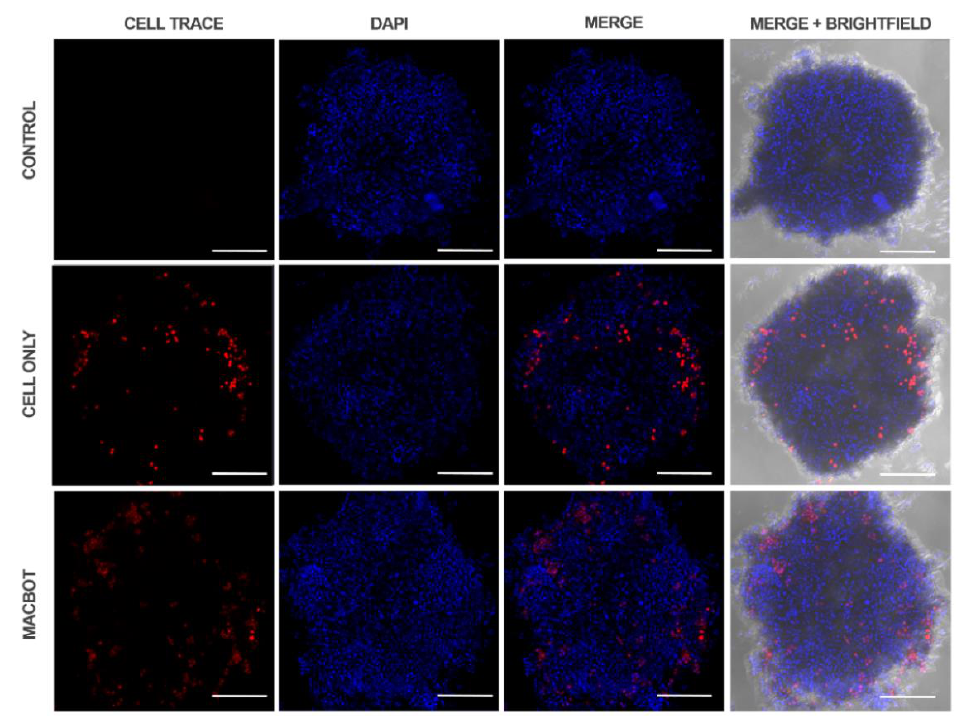
Figure 9. Penetration of the macrophage cells/Macbots into A549 tumor spheroids. The macrophages and microrobots were stained with CellTrace TM Far Red (red), and the spheroids were counterstained with DAPI (blue). Scale bars 200 μm.